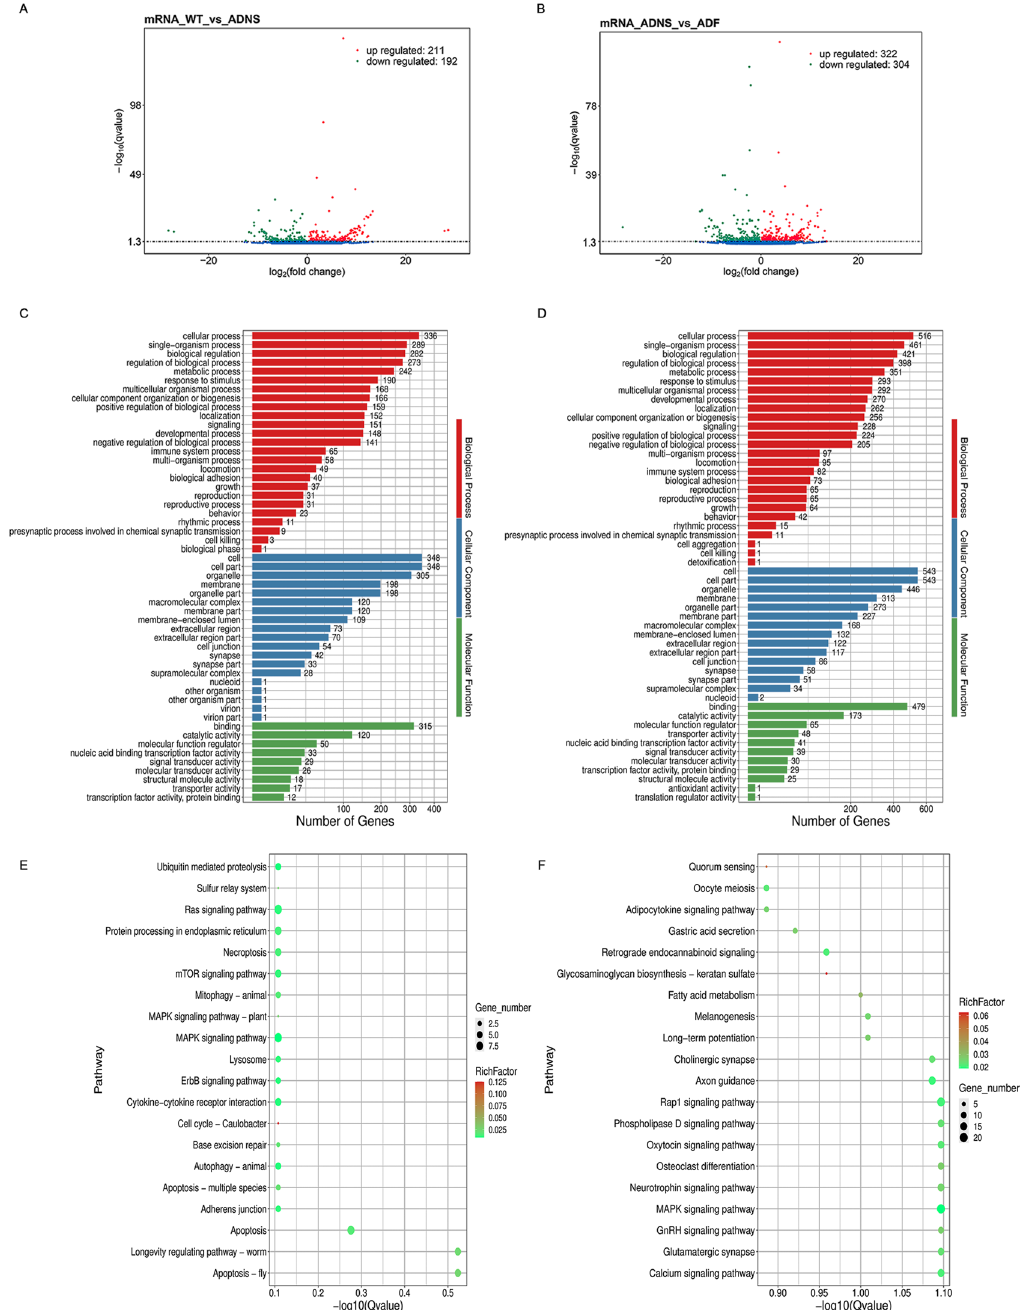
Figure 2. Differentially expressed mRNAs in the hippocampal tissues from mice in each group. ( A ) The number of upregulated and downregulated mRNAs between WT and ADNS are shown; 403 (211 up and 192 down) differentially expressed mRNAs (DEMs) between WT versus ADNS. (B) The number of upregulated and downregulated DEMs between ADF and ADNS are shown; 626 (322 up and 304 down) DEMs were identified between ADNS versus ADF. (C) GO annotations of 403 DEMs in WT versus ADNS. The mRNAs were significantly enriched in 1103 GO terms ( p < 0.05). (D) GO analysis of 626 DEMs in ADNS versus ADF. The mRNAs were significantly enriched in 1199 GO terms ( p < 0.05). (E) KEGG pathways involving the top 20 terms in WT versus ADNS. A larger Rich Factor value indicates a higher degree of enrichment. DEMs between WT-ADNS were enriched from cell growth and death pathways including the cell cycle and apoptosis pathway. (F) KEGG pathways involving the top 20 terms in ADNS versus ADF. DEMs between ADNS-ADF were enriched from nervous system pathways including neurotrophin signaling pathway, glutamatergic synapse, cholinergic synapse, long-term potentiation and retrograde endocannabinoid signalling (KEGG pathways: https:// www. kegg. jp/ kegg/ kegg1.